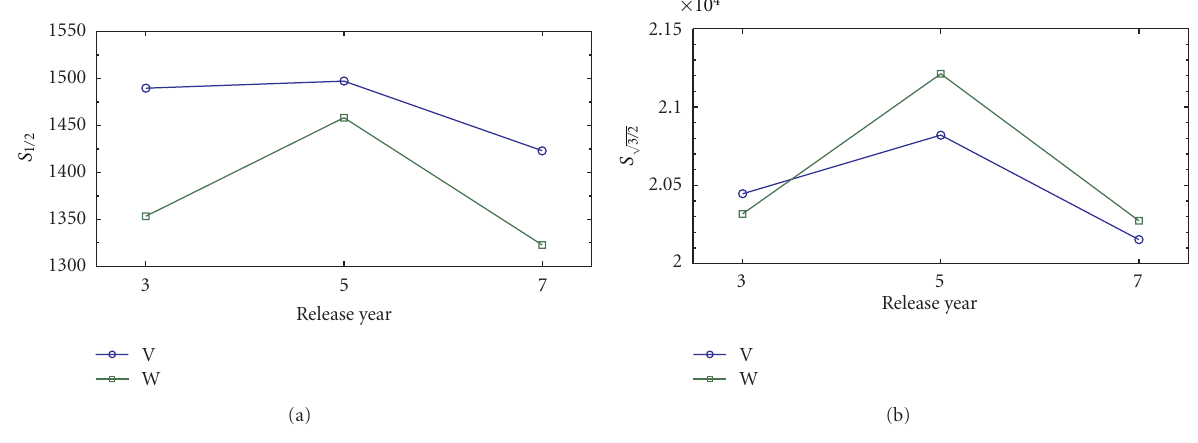
Figure 18: S statistics of WMAP 3-, 5- and 7-year data.